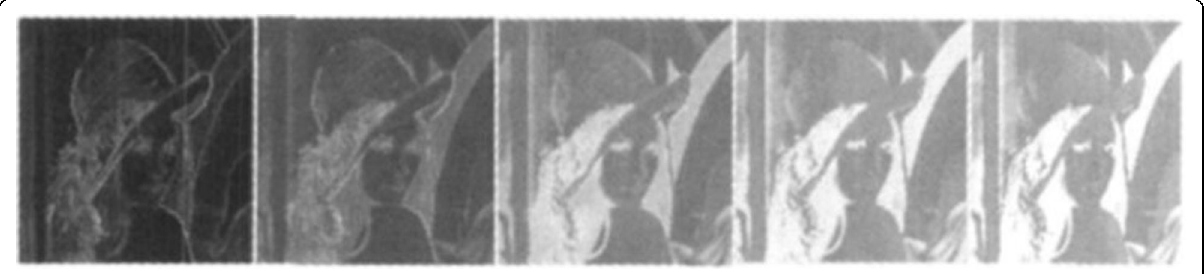
Fig. 5 Texture image of Lena. a = 0.1. a = 0.3. a = 0.5. a = 0.7. a =